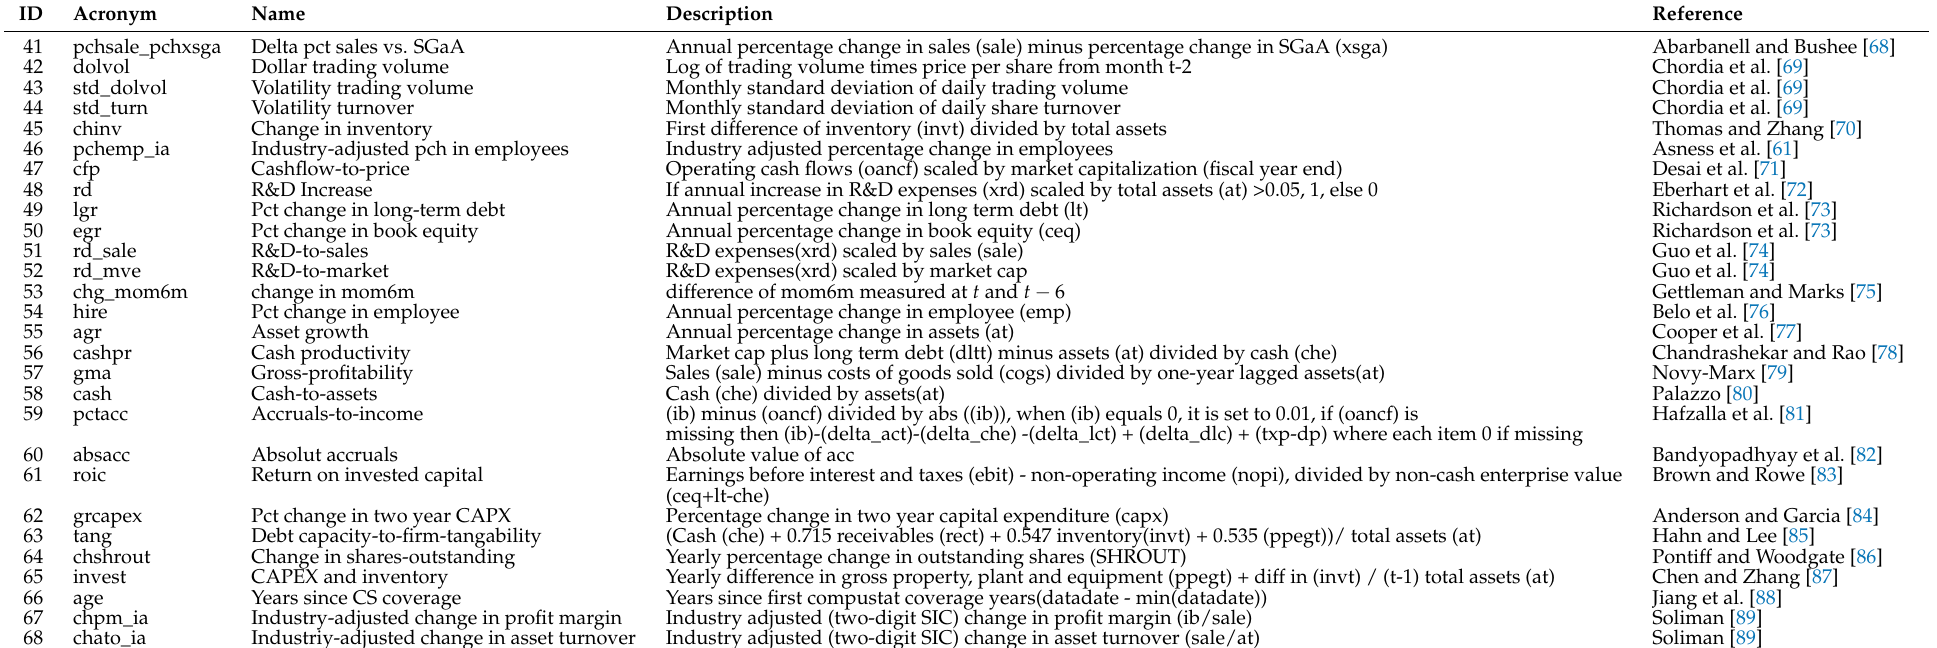
Table A3. The table displays the firm characteristics used. Most definitions are taken from Green et al. [3]. If not otherwise stated, accounting ratios always refer to fiscal year end